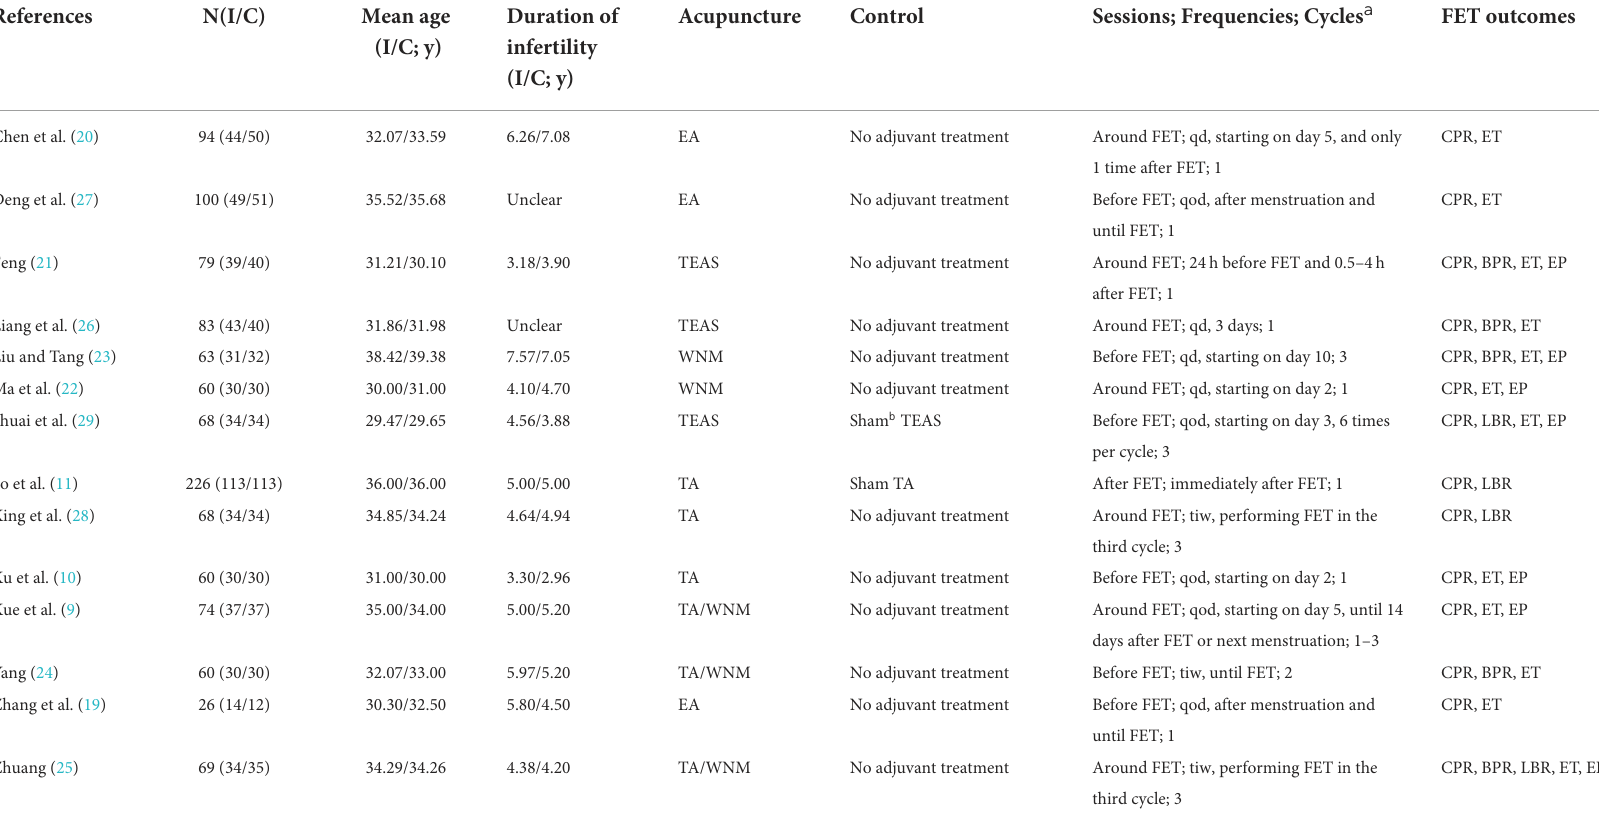
TABLE 1 Characteristics of included